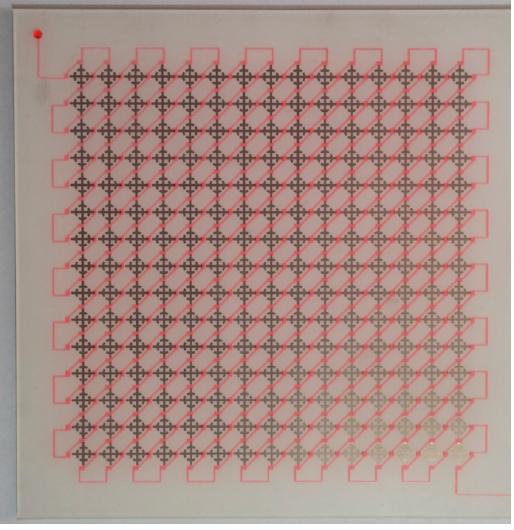
Figure 6. Fabricated prototype sample after injecting DI water. DI water was mixed with red ink in order to clearly see the liquid path.